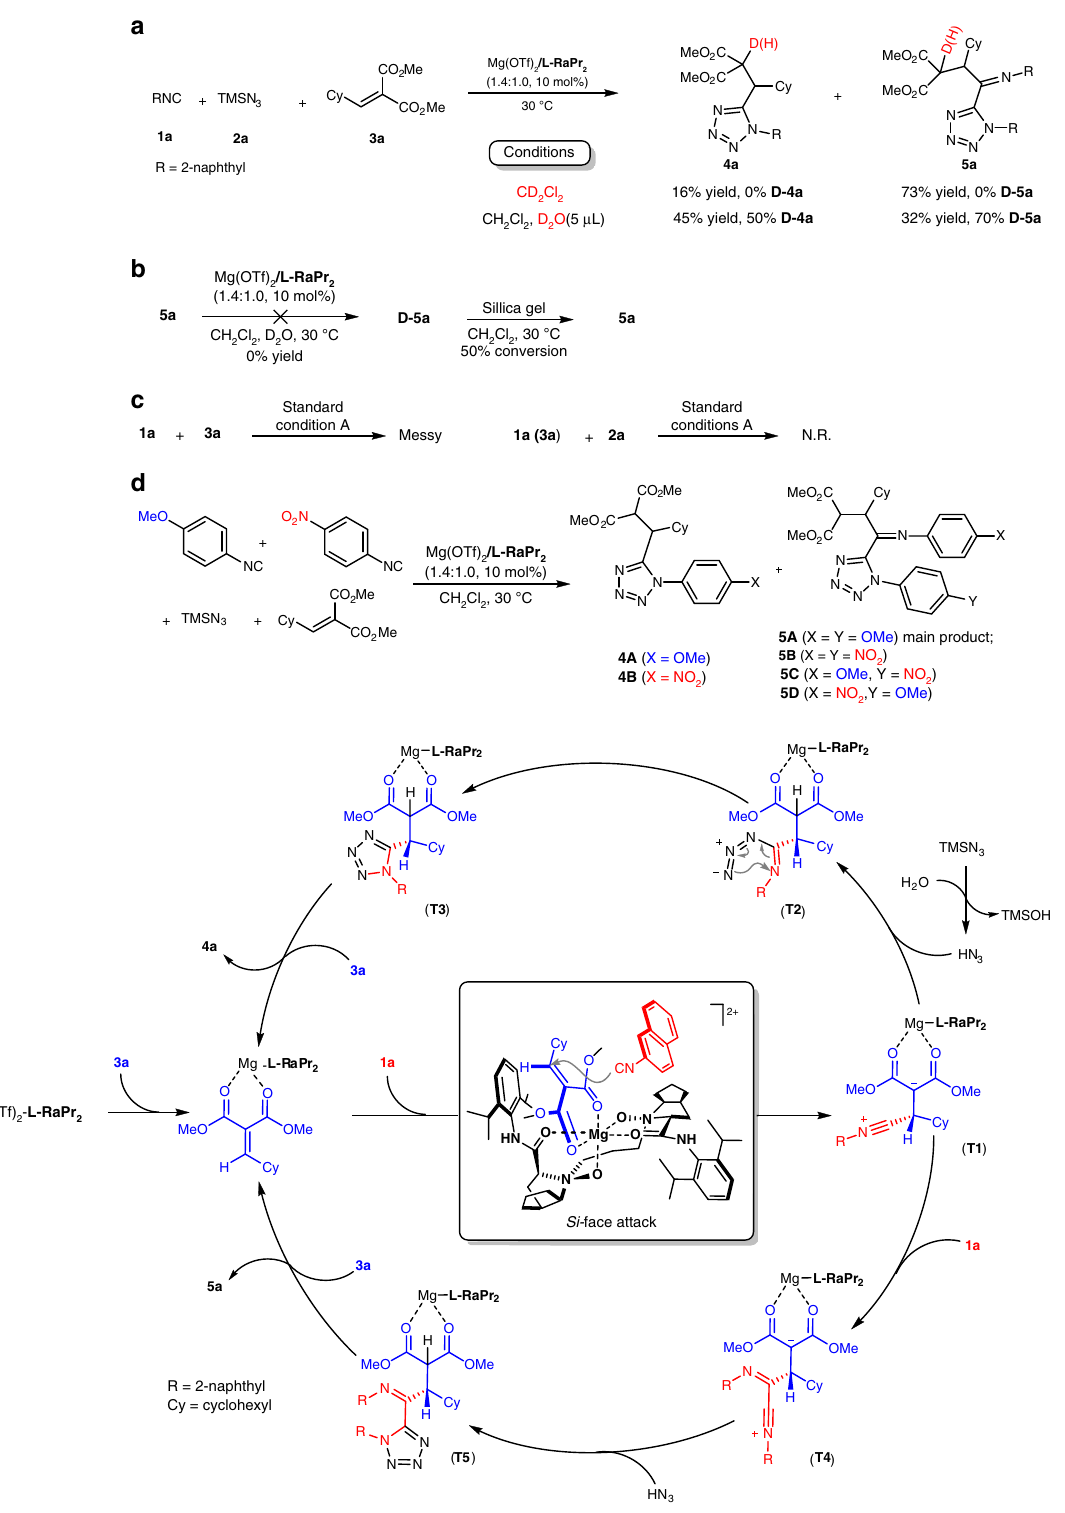
Fig. 5 Control experiments and proposed catalytic cycle. a Deuterium labeling experiments. b Control experiments for 5a and D-5a . c Control experiments for two materials. d NMR spectra and HRMS for reaction involving two different isocyanides. e Proposed catalytic cycle for IMCRs 50% deuterium) was isolated as the main product instead of 5a deuterated dichloromethane was used as the solvent, the four- (with 70% deuterium). In addition, the percent of deuterated 5a component product 5a without deuterium was obtained as the decreased from 70 to 35% by treatment with silicone gel (Fig. 5b). major product ( 4a : 16% yield, 5a : 73% yield). While the addition These results not only indicated that the proton came from a of a small amount of D 2 O (5 μ L) dramatically affected the ratio of two products. In this case, three-component product 4a (with trace amount of water or work up with silicone gel but also NATURE COMMUNICATIONS| (2019) 10:2116